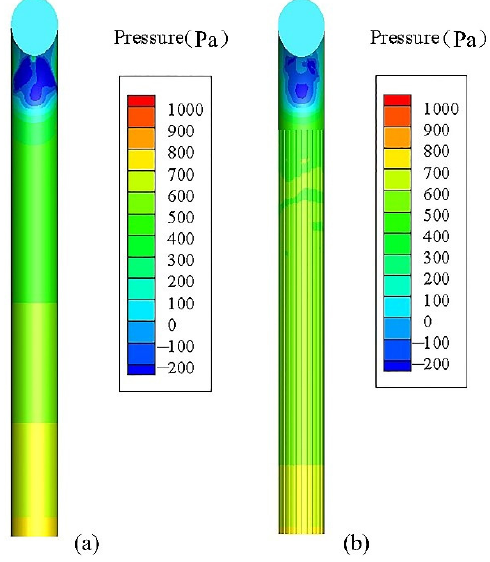
Figure 13. Comparison of pressure nephogram: ( a ) prototype and ( b ) bionic tailpipe.